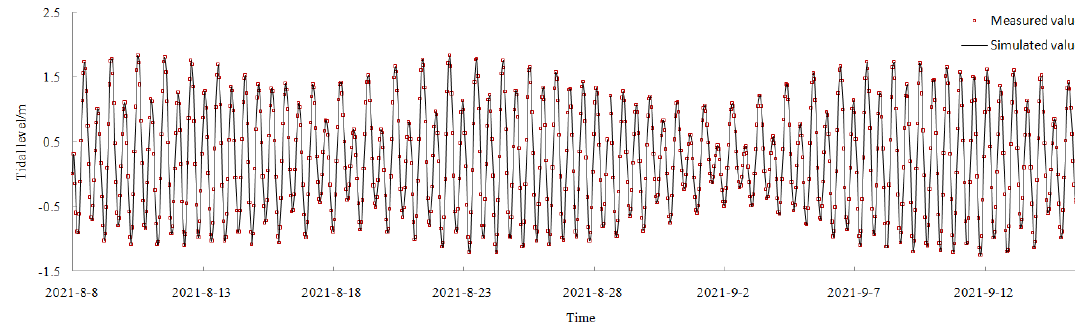
Figure 5. Tidal-level verification map of T1.